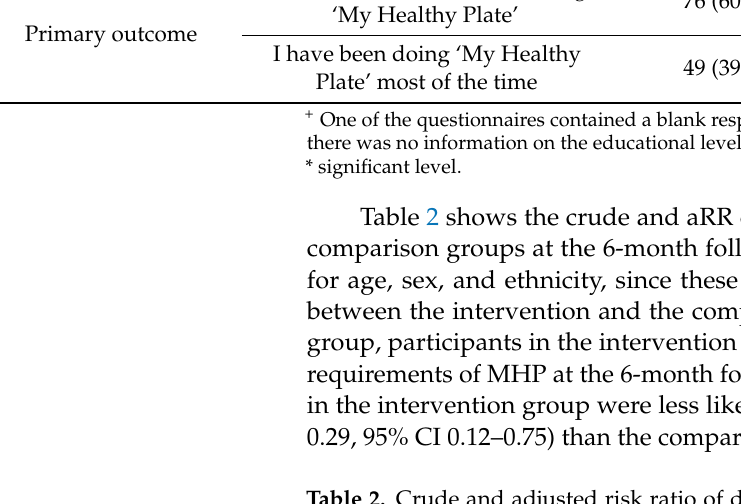
Table 2. Crude and adjusted risk ratio of dietary behaviours of the intervention and comparison groups at 6-month